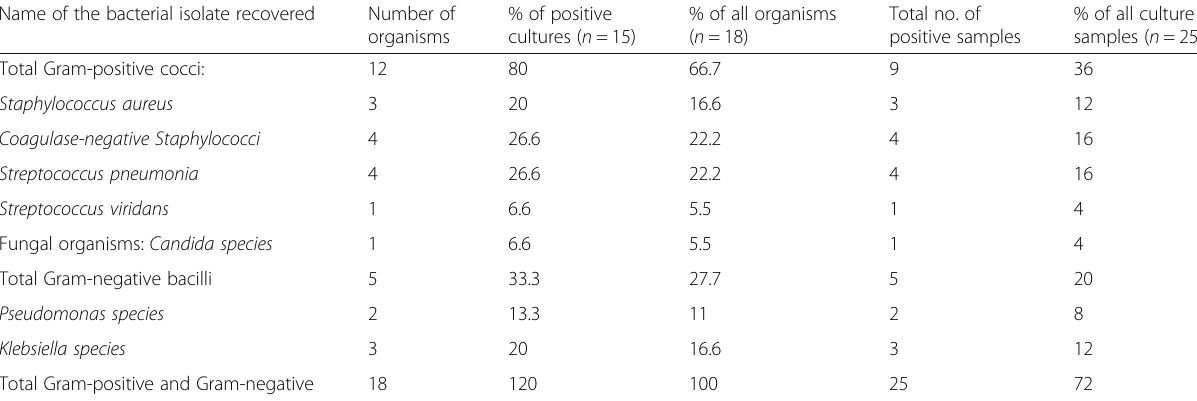
Table 2 The number and percentage of bacterial isolates from dacryocystitis cases Name of the bacterial isolate recovered Number of